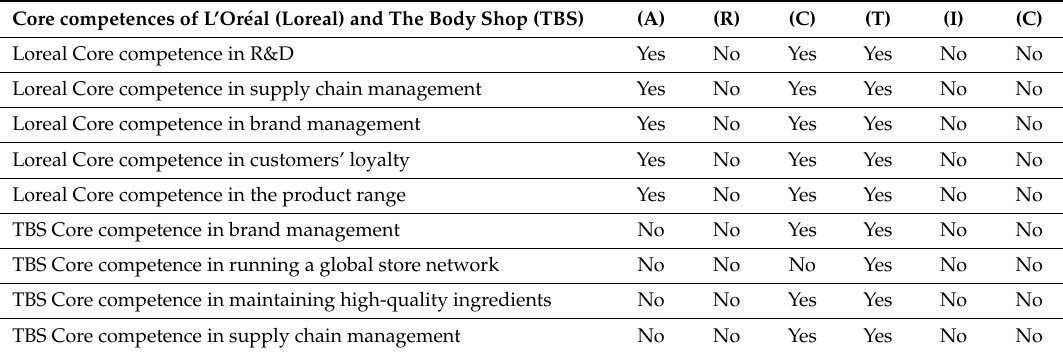
Table 1. The ARCTIC (A—Advantage, R—Relatedness, C—Complexity of Competence, T—Time of Integration, I—Implementation Plan, C—Cultural Fit) framework for the pre-acquisition analysis of competence-based synergies (L’Or é al’s acquisition of The Body